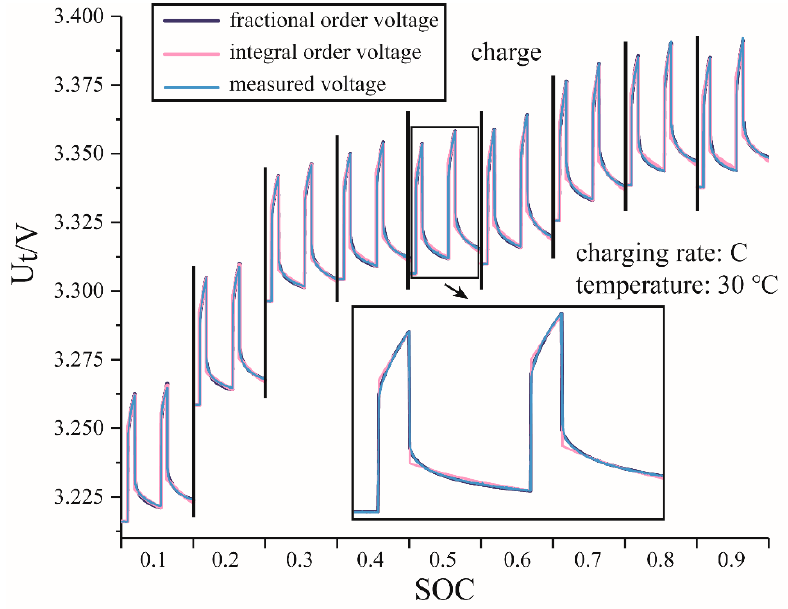
Figure 10. Terminal voltage fitting results from charging identification test at 30 ℃ in different SOC.